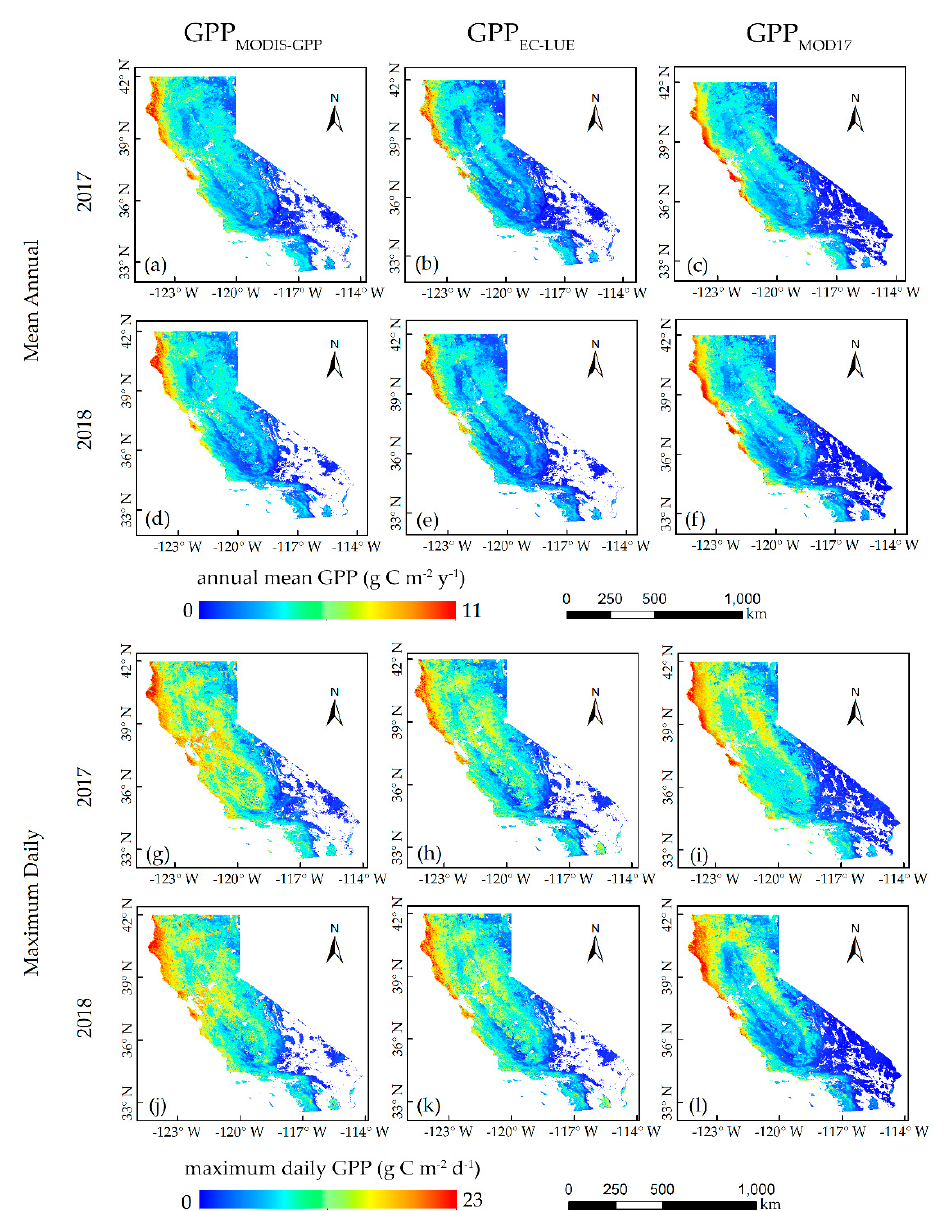
Figure 8. Spatial distribution of the annual mean GPP from the MODIS-GPP algorithm ( a , d ), EC-LUE model ( b , e ), and MODIS-GPP products ( c , f ) in 2017 and 2018 and the maximum daily GPP from the MODIS-GPP algorithm ( g , j ), EC-LUE model ( h , k ), and MODIS-GPP products ( i , l ) in 2017 and 2018.